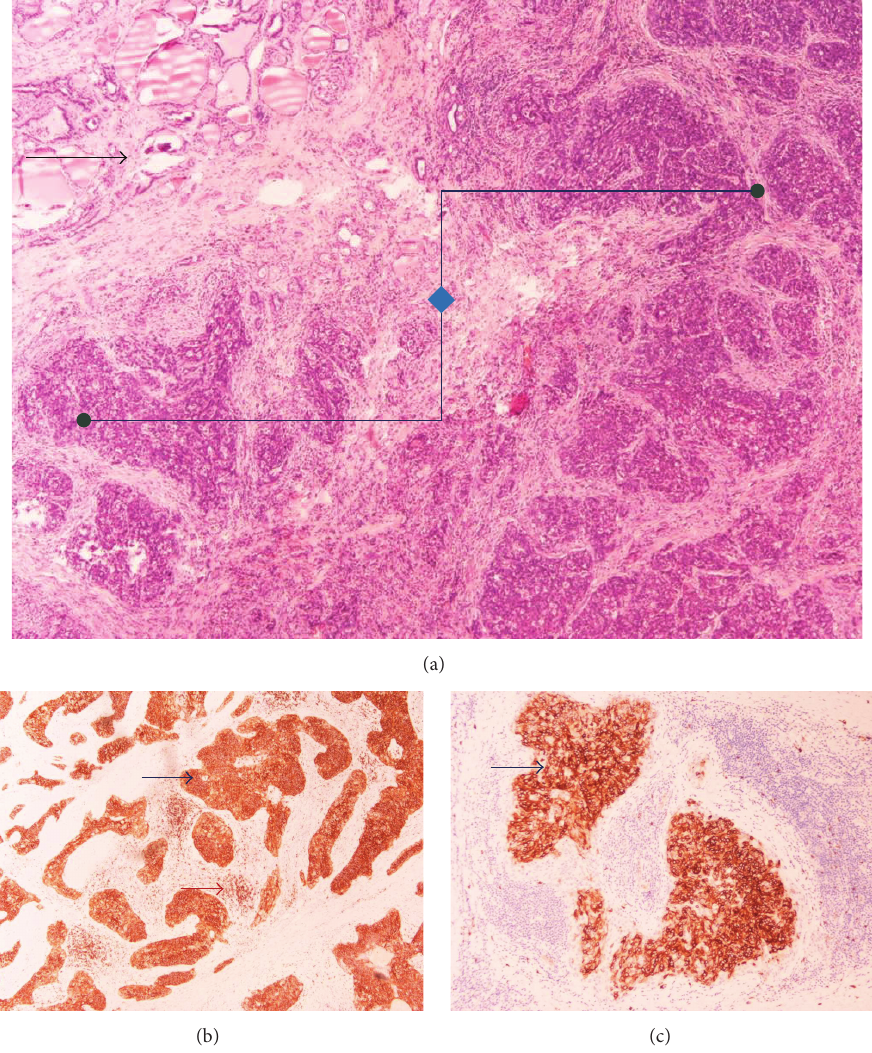
Figure3:Pathologyofthetumour.(a)Thymiccarcinoma(rightpartofpicture/angularline)andinfiltratedthyroidgland(upperleftquadrant of the picture/black arrow) (H&E stain, × 40), (b) Cd5 expression in thymic carcinoma cell (blue arrow) and in lymphocytic T-cell thymic population (red arrow) (IHC, × 100), and (c) CD117 expression in thymic carcinoma (arrow) (IHC, × 100).